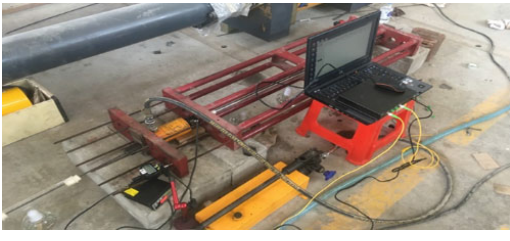
Fig. 9 Test device.